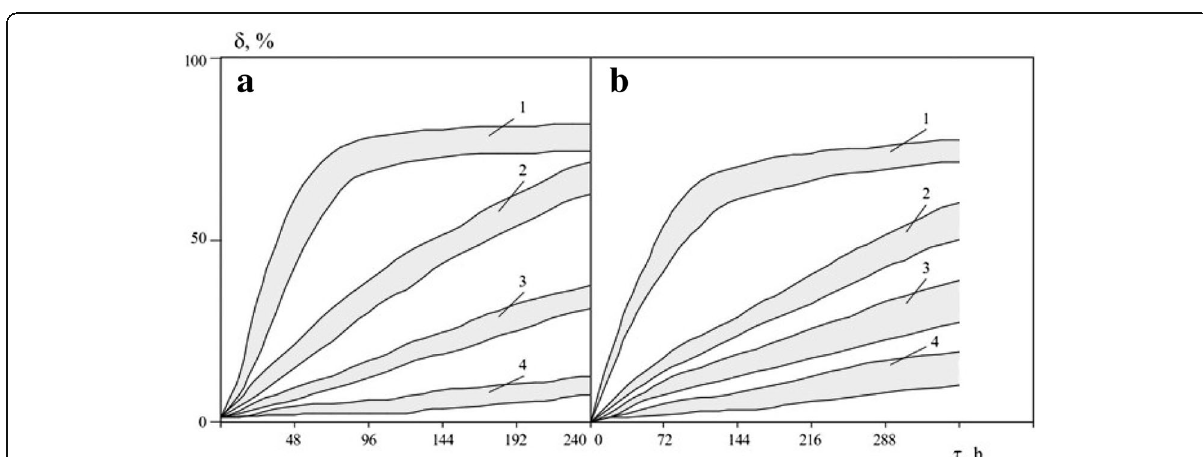
Fig. 3 Dissolution degree values areas for nanopowders of borides ( a ) and carbides ( b ) of zirconium, titanium, vanadium, chromium, molybdenum, and tungsten in electrolytes solutions: T =323 K; electrolyte pH value — 2.5 ( 1 ), 3.0 ( 2 ), 3.5 ( 3 ), and 5.0 ( 4